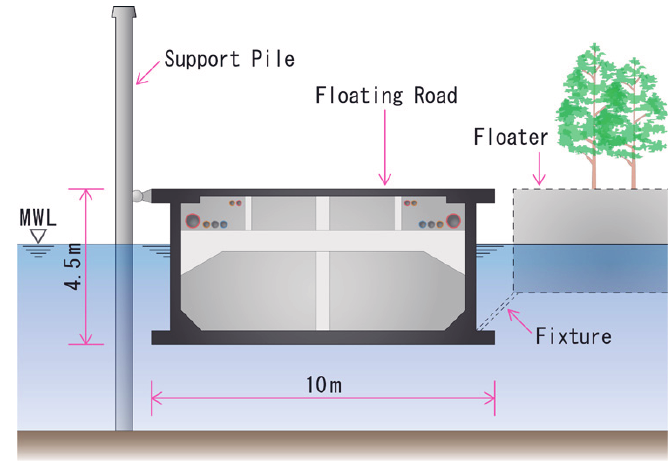
Figure 12. Detailed sectional view of the floating road with support